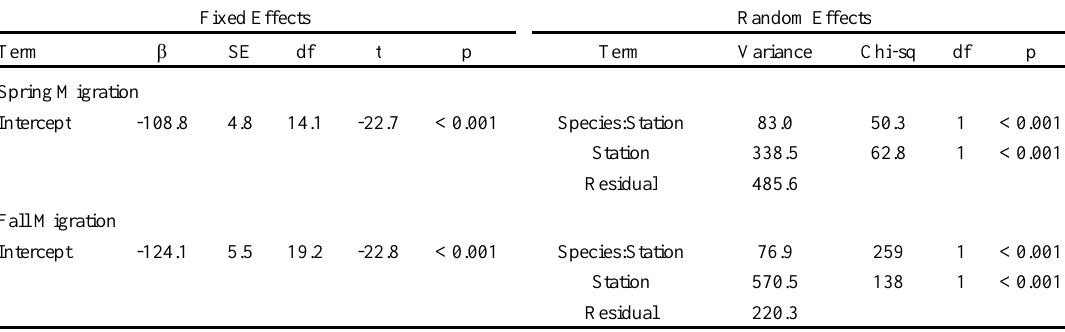
Table 5. Random effects model results examining variation in δ ²H in bird feathers during spring migration (n = 966) versus fall migration (n = 1637) in relation to Canadian Migration Monitoring Network station and species nested within station (see